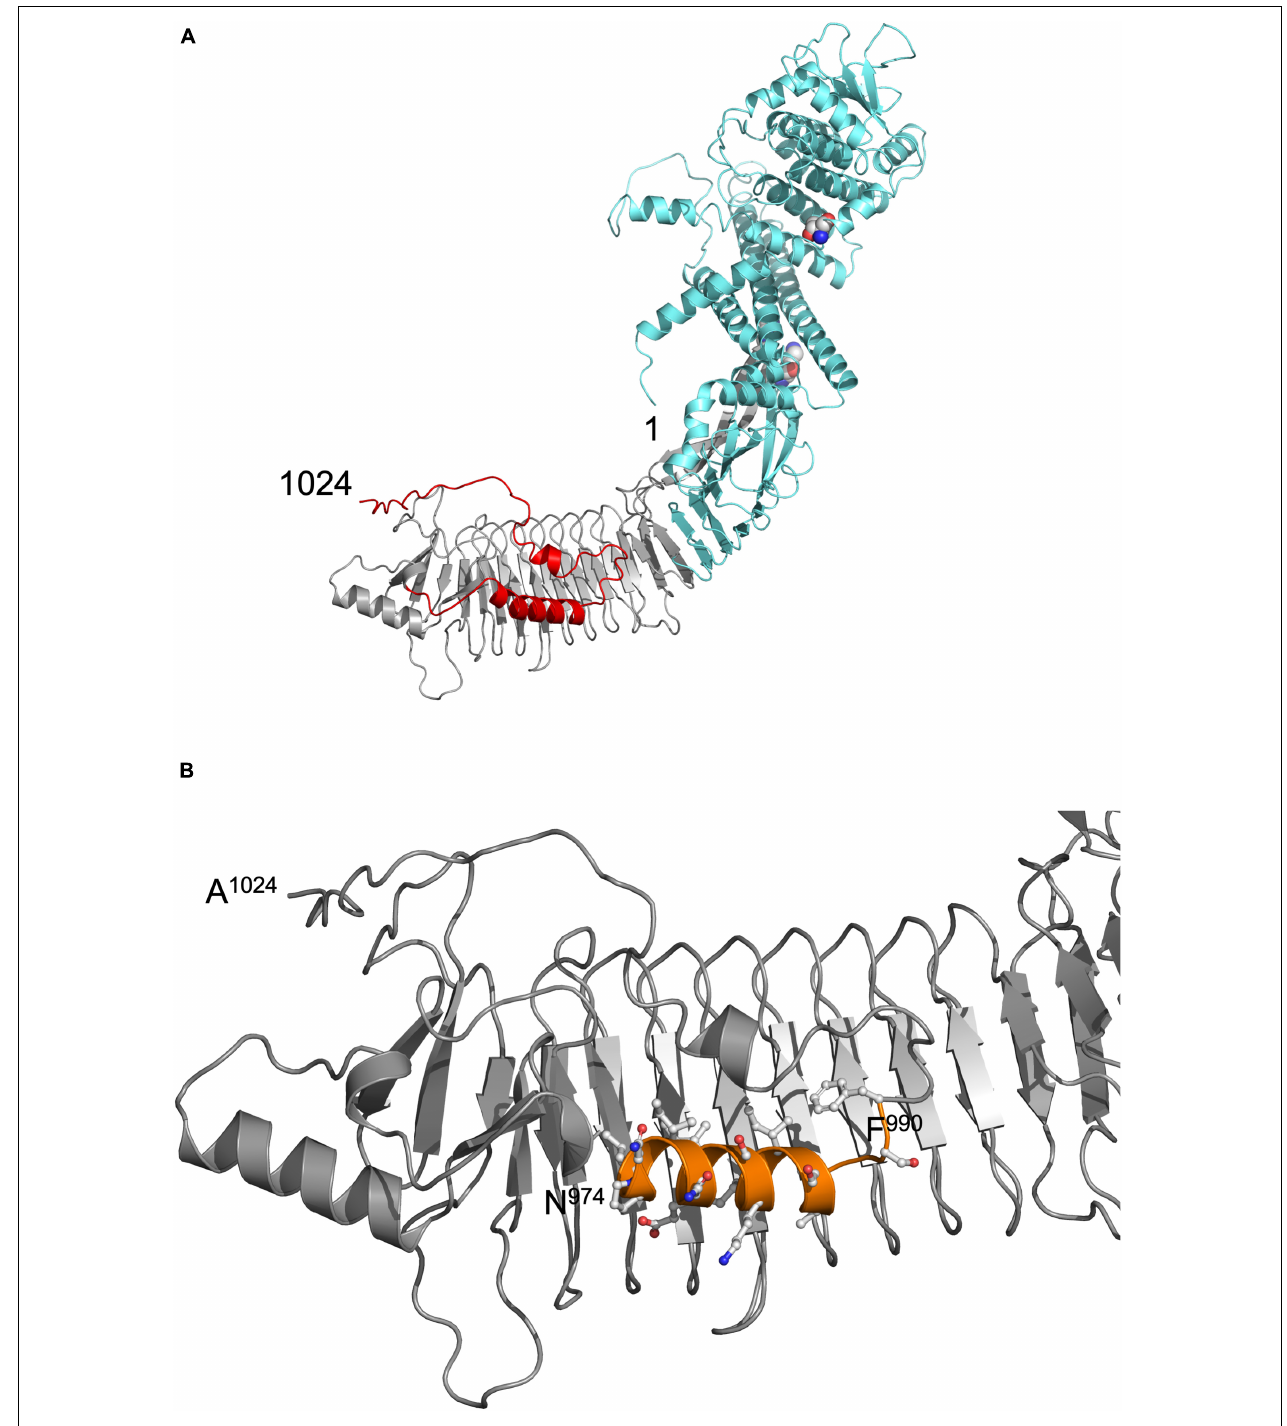
FIGURE 1 | (A) Model of pro-HlyA predicted by AlphaFold (Jumper et al., 2021). The N- and C-termini are indicated by numbers (1 and 1024, respectively). The secretion signal is highlighted in red, the RTX in gray and the N-terminal pore-forming domain in cyan. The two Lys residues (K564 and K690) that are acylated by HlyC prior to secretion are highlighted as spheres. (B) Zoom in into the C-terminal region of the structural model of folded pro-HlyA. The C-terminus (A 1024 ) as well as the positions of residues N 974 and F 990 are indicated. The amphipathic helix is shown in orange with the side chains in ball-and-sticks representation. Hydrophobic residues are clearly located on one side of the helix, while polar and charged residues are located on the opposite side. The Repeat in ToXins (RTX) domain, which adopts a β -roll structure even in the absence of Ca 2 + ions, is oriented toward the back of the representation.